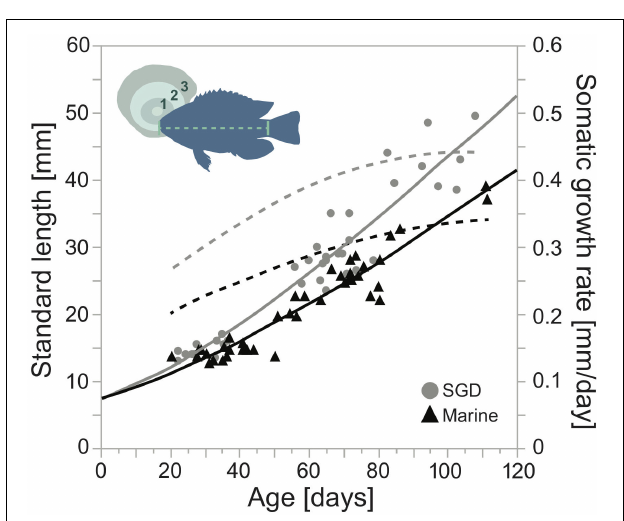
FIGURE 4 | Relationship between standard length (light green dashed line, mm), somatic growth rates (mm per day), and age (days) as deducted from otolith (green) increment counts (dark green numbers) in juvenile Chrysiptera glauca (blue silhouette). Gray and black solid lines represent Gompertz growth curves (GGC), gray and black dashed lines represent growth rates (mm per day) calculated from first derivative of the GGC. Gray circles indicate individuals sampled inside a tide pool influenced by fresh submarine groundwater seepage (SGD), and black triangles those sampled in a strictly marine tide pool